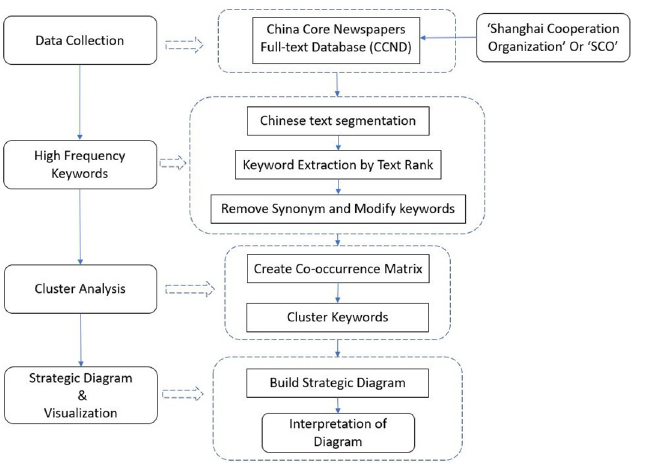
Fig 2. The flow chart of methodology in this study.